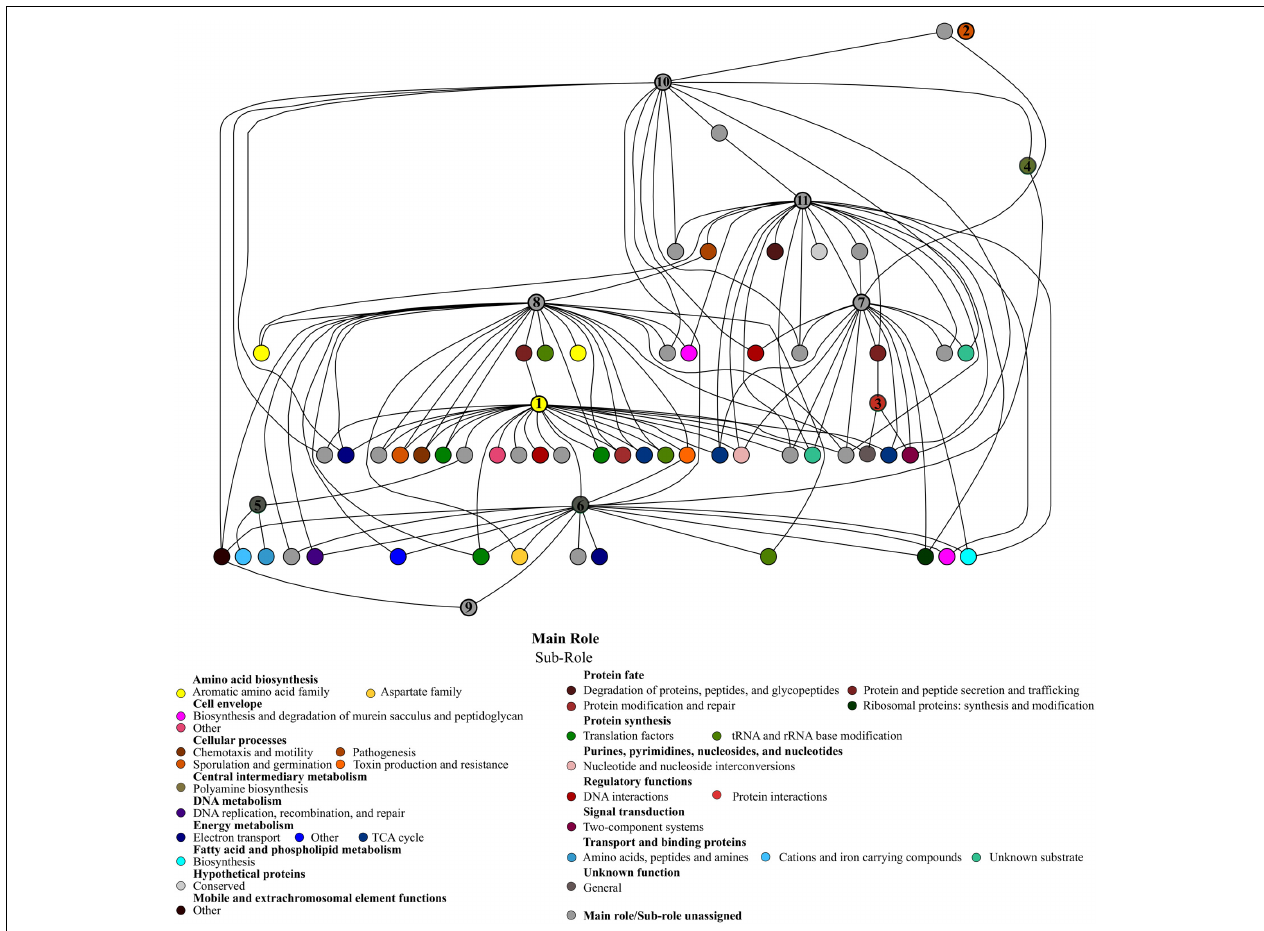
FIGURE 5 | Bayesian network of microbiota potential functions in CD − samples of patients (A–E), during treatment, and the protective candidate taxa. The significant positive correlations ( p -value < 0.01) between the candidate protective functions and other functions of the gut ecosystem are shown. Each node represents a specific function with the corresponding subrole color. The candidate protective function nodes are